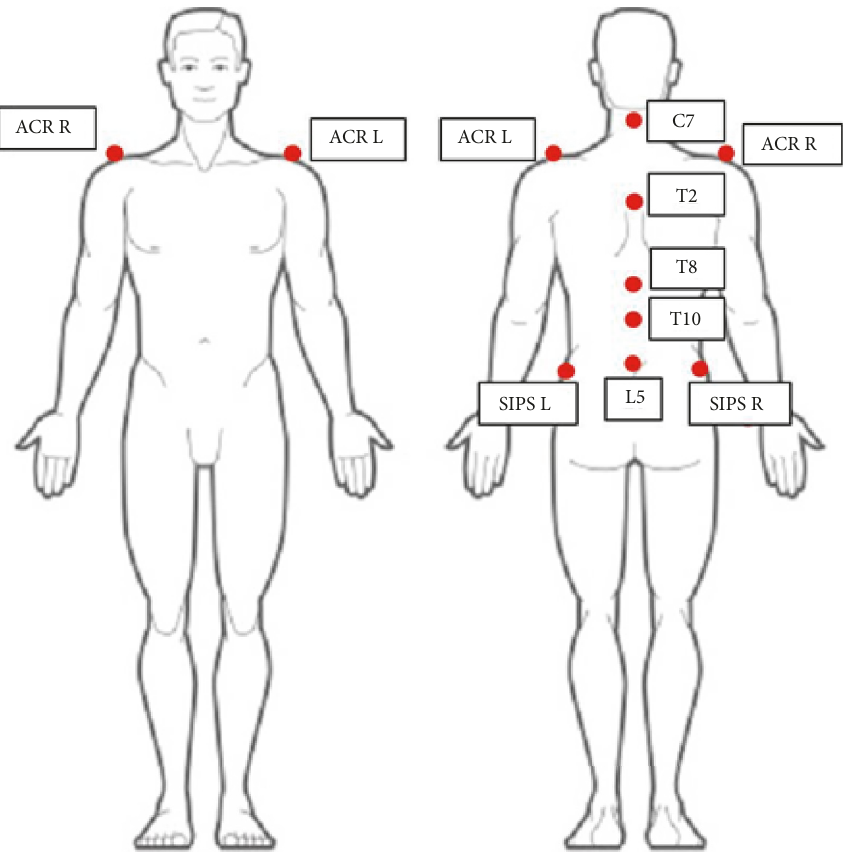
Figure 1: Reference points for the markers placed for the trunk motion task. SIPS, superior iliac posterior spine; ACR, acromion.